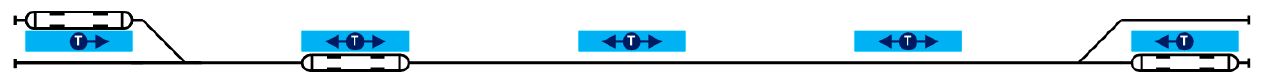
Figure 7. Using the bi-directional tram to serve tram stops located on one side of the track.